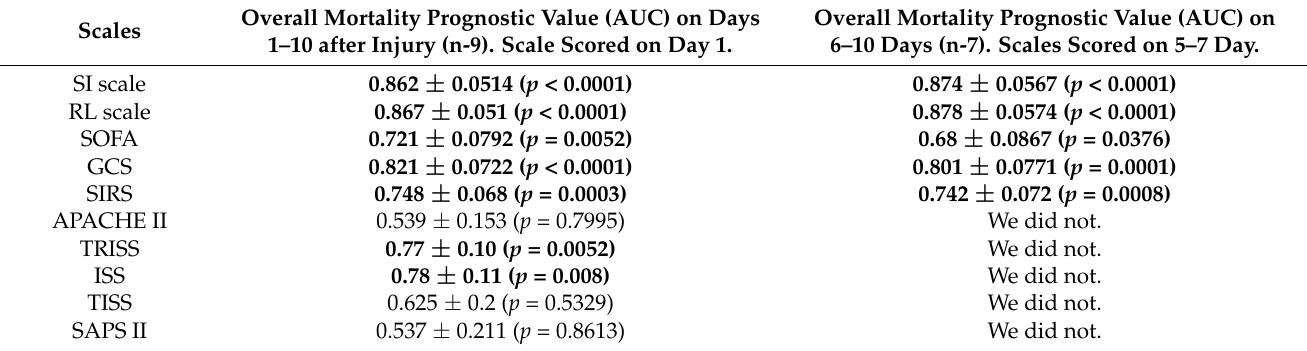
Table 7. Area under the ROC curve (AUC ± standard error) for the studied scales in the prognosis of fatal outcomes in patients (n-37) with predominantly chest injury. Overall Mortality Prognostic Value (AUC) on Days 1–10 after Injury (n-9). Scale Scored on Day